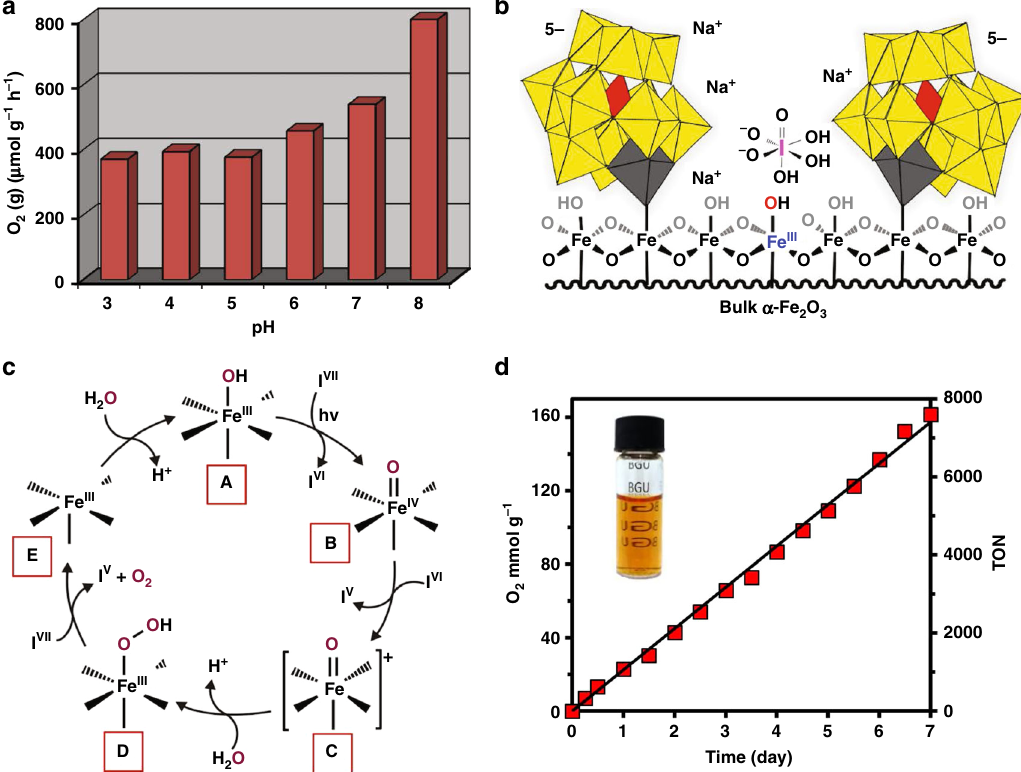
Fig. 4 Visible-light driven water oxidation by 1 . a Rate of O 2 formation (per gram of α -Fe 2 O 3 in 1 , per hour), for 2.4 μ M 1 and 20 mM NaIO 4 , as a function of pH. b Scale model showing the relative sizes and plausible locations of cluster-anion ligands, [ α -PW 11 O 39 Fe] – O – , Na + counter-cations, and orthoperiodate ([H 3 I VII O 6 ] 2 – ) at a surface of the α -Fe 2 O 3 core of 1 . The Fe(III) atoms at the hematite surface are six coordinate, and at pH 8, are terminated by hydroxide ligands. c A plausible catalytic cycle for photochemical water oxidation, highlighting proposed elementary steps, with the active site comprised of a single Fe III atom at the surface of the Fe 2 O 3 core (highlighted by blue text in panel b). See text for details. d Dioxygen produced by 1 (5.4 μ M) as a function of time during 7 days of reaction at pH 8. Oxygen production is plotted in mmol O 2 per g of α -Fe 2 O 3 in 1 (as routinely done for colloidal metal-oxide catalysts), and the turnover number (TON) is de fi ned as mol O 2 per mol 1 , as is typical for molecular catalysis. The initial concentration of NaIO 4 was 20 mM. During the course of the 1-week reaction, the solution was periodically charged with additional NaIO 4 , and separated from accumulated iodate (IO 3 – ) (see the Methods section for details). The starting pH value and those after 7 days, were 8.0 and 8.2, respectively; the buffering was provided by orthoperiodate, for which p K a 2 and p K a 3 are ca. 7.5 and 11, respectively